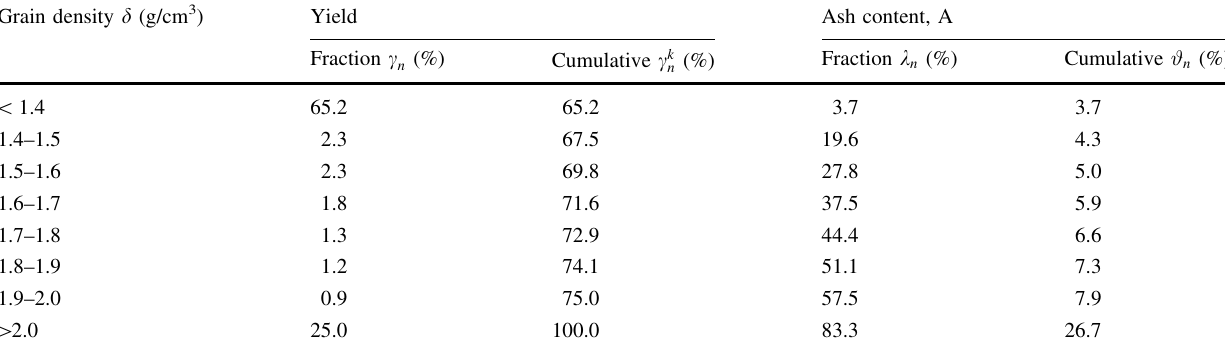
Table 1 Density distribution of material No. 1 (grain-size class: 0–20 mm) Grain density d (g/cm 3 )